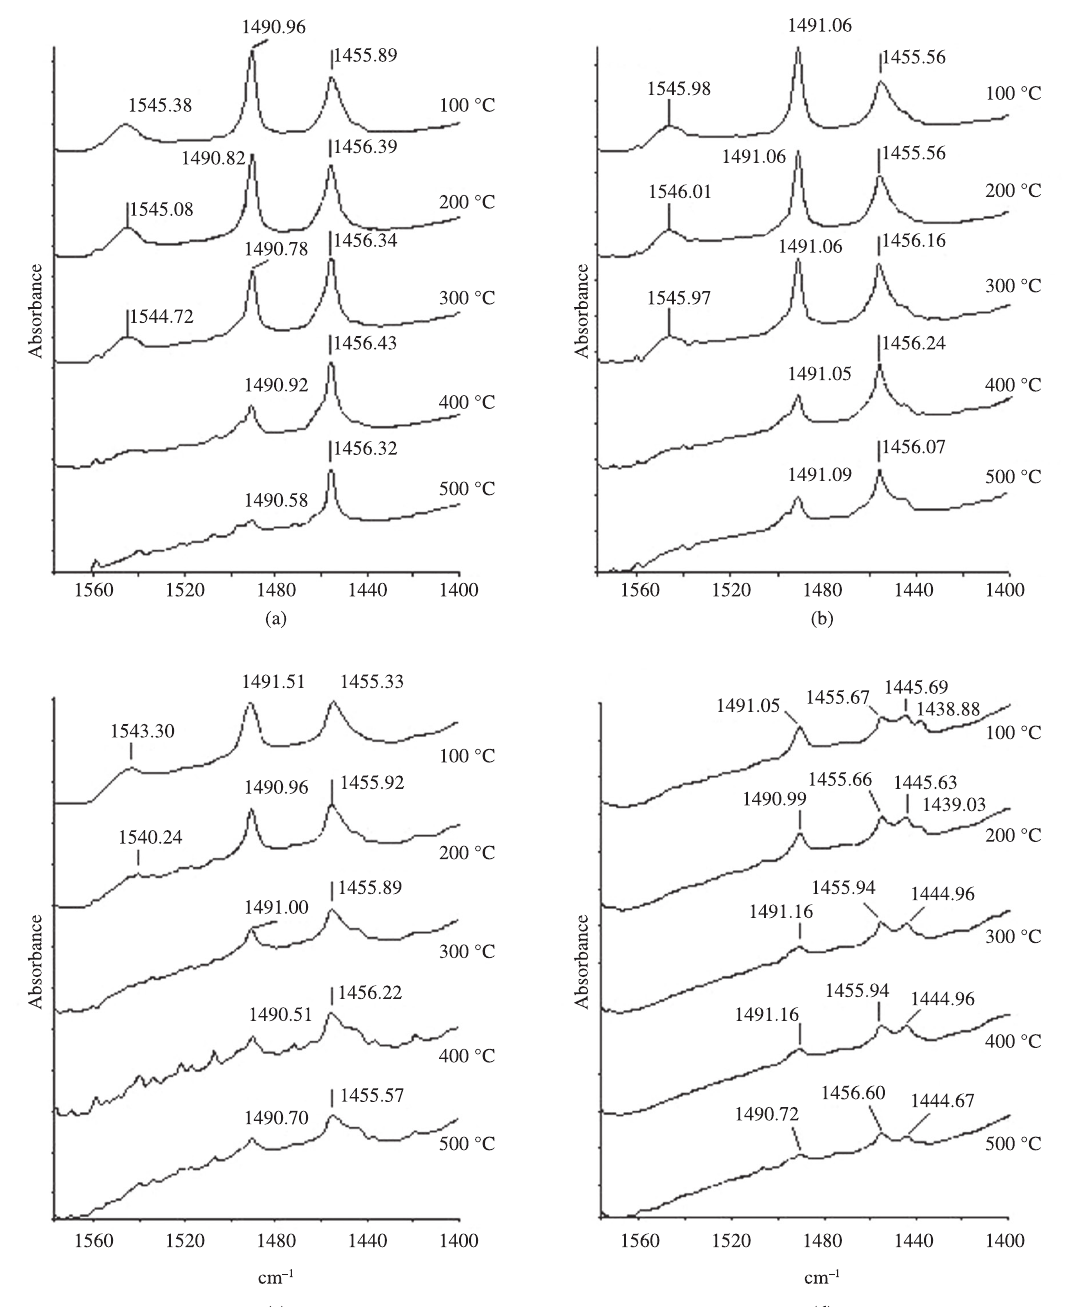
Figure 11. Behavior of the FTIR spectra between 1560 and 1400 cm –1 , with the increase of pyridine desorption temperature of zeolite samples a) NHT, b) HT560, c) HT760 and d)